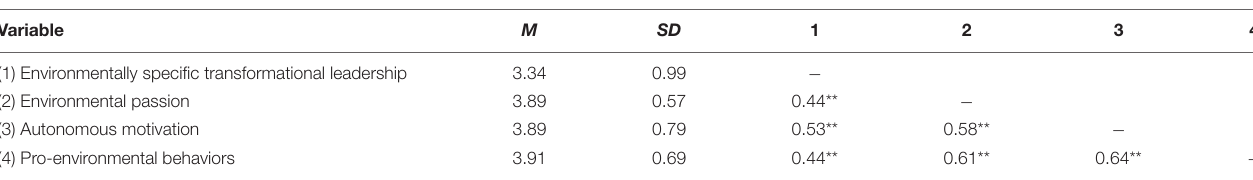
TABLE 2 | Means, standard deviations and intercorrelations among variables.